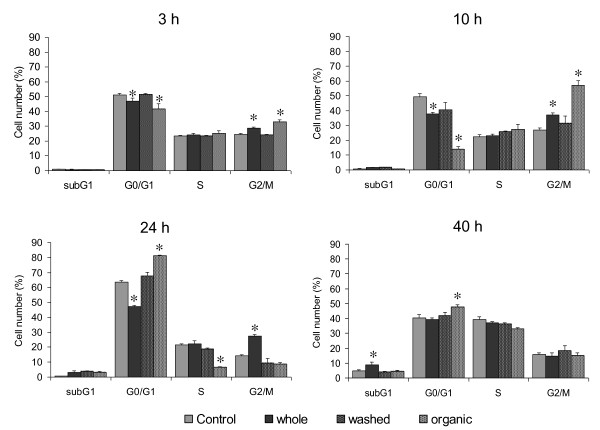
PM fractions effect on the cell cycle. BEAS-2B cells were exposed for 3, 10, 24 and 40 h to 7.5 μg/cm2 of whole-PM, the equivalent amount of organic fraction and washed particles. The results are representative of 3 independent experiments. *Statistically significant difference from untreated cells (control), P < 0.05.